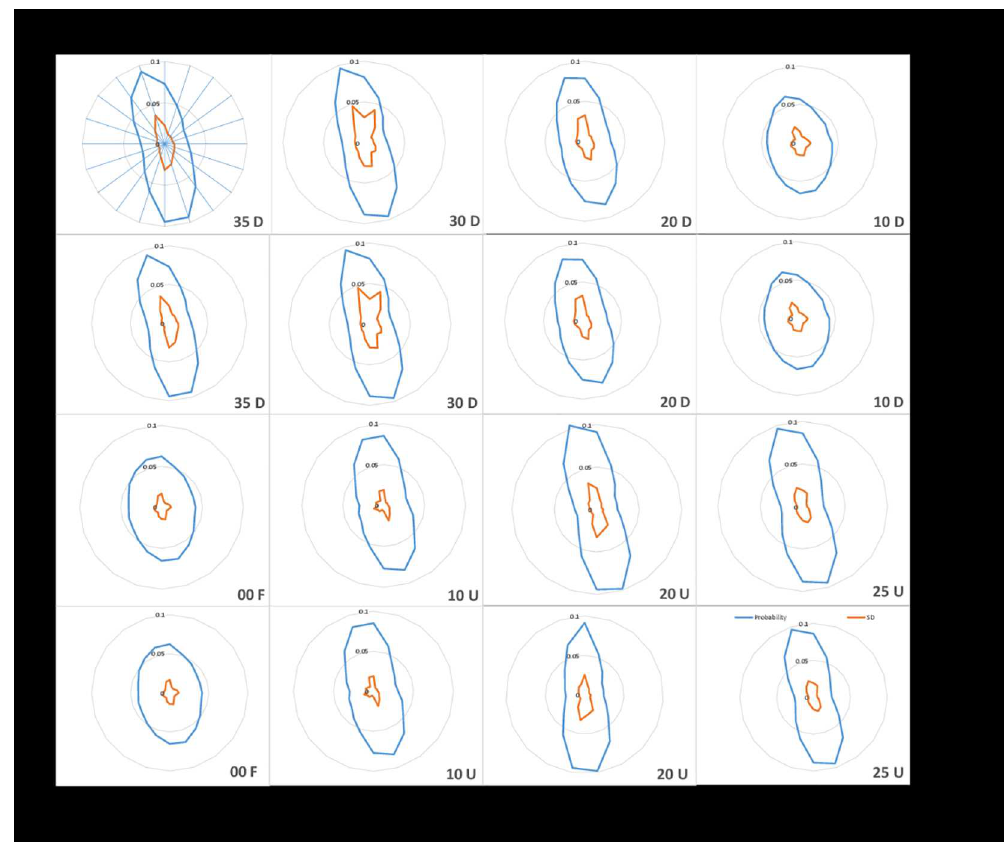
Fig 5. Group mean (n = 17) with between-S standard deviation for polar distribution of VTC mean magnitude and probability of a virtual contact across 20 boundary segments as a function of sloped platform conditions using CoP data. 1 st and 3 rd Row – VTC mean (s), 2 nd and 4 th Row – Probability of